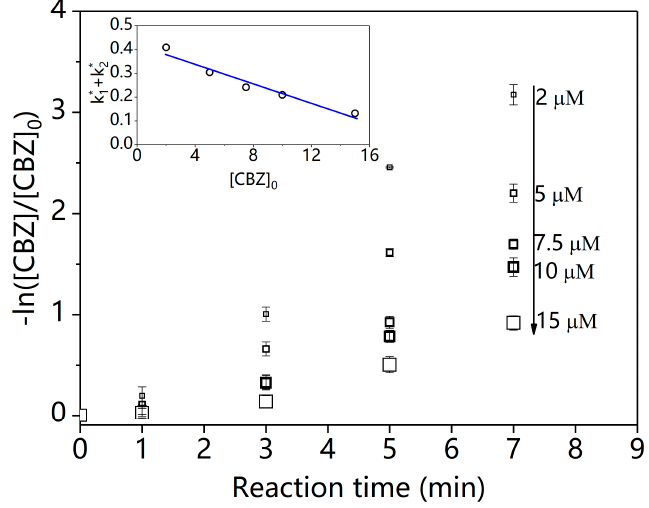
Figure 8. The degradation performance of CBZ by BiOBr/PMS process at different initial concentration of CBZ. BiOBr dose 0.5 g · L − 1 , [PMS] 0 = 4.0 mM, pH = 7.0, T = 24 ◦